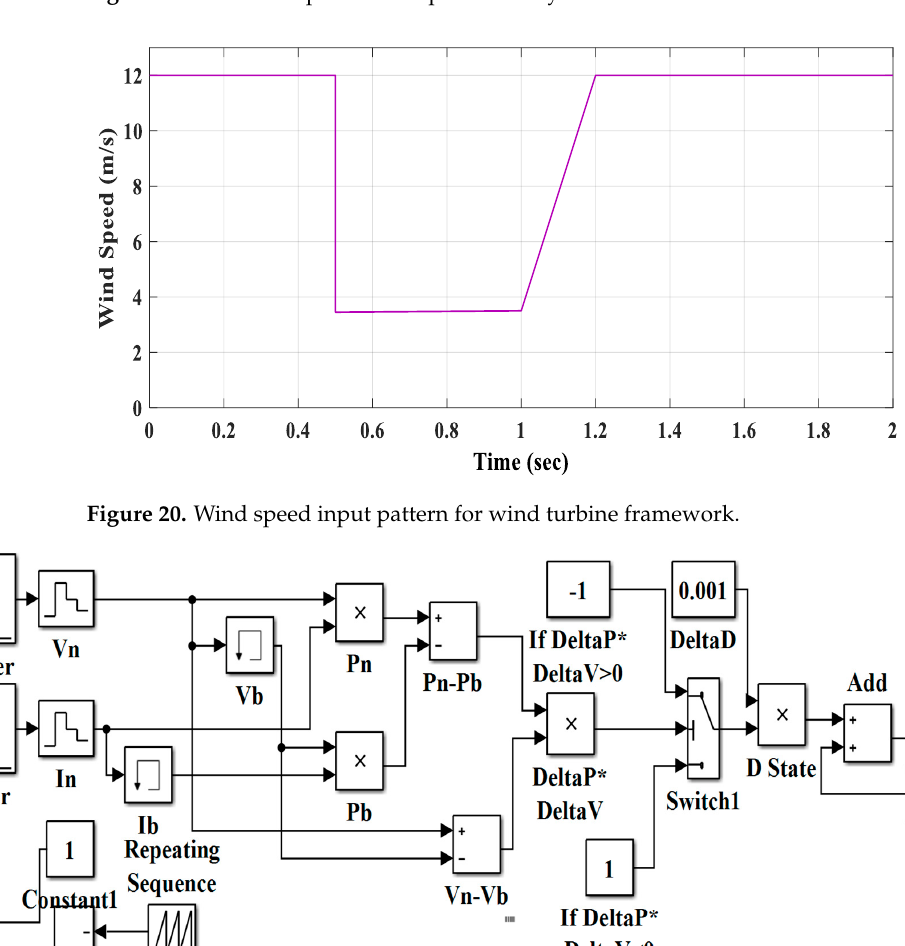
Figure 22. Subsystem of fuzzy logic controller.